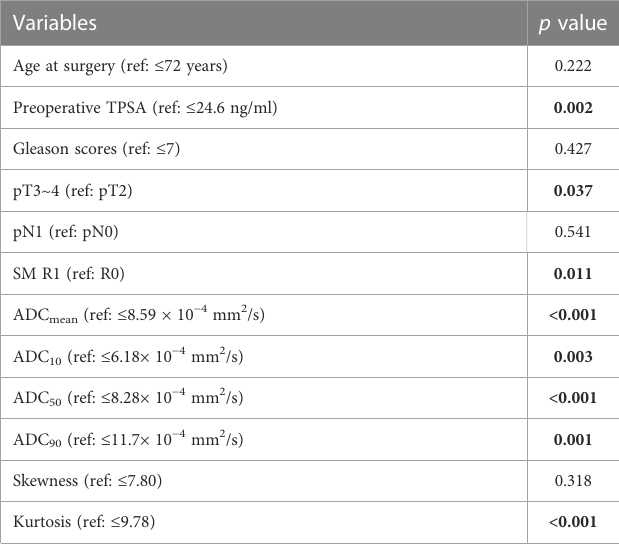
TABLE 2 Univariable analysis of BCR-fs by K-M analysis and log-rank test.